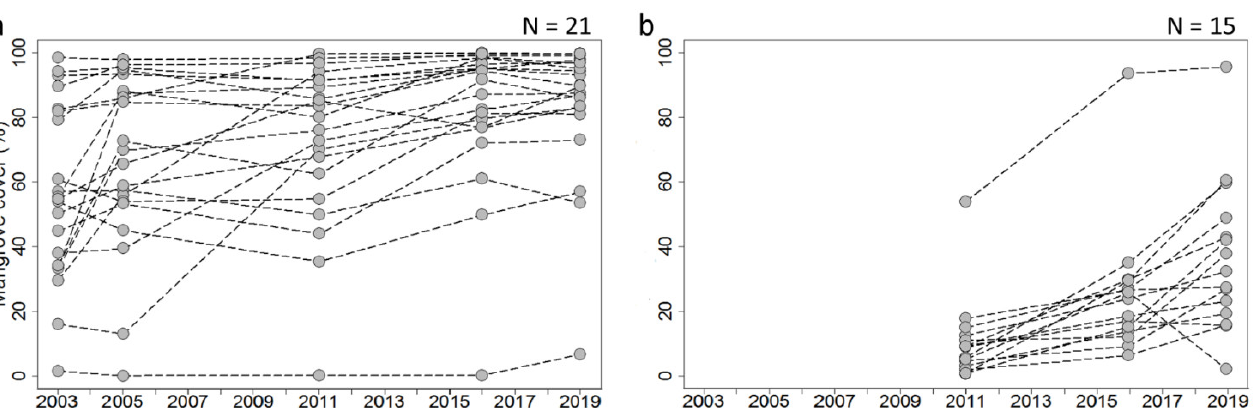
Figure 8. Changes observed in the land-cover of Pichavaram mangroves and the surrounding areas from the visual inspection of the VHRS images (image excerpts on the right ) in combination with a 2016 color-composite image provided by Google Earth ( left ). Aquaculture expansion in the vicinity of the mangrove forest ( a – e ), check-dam construction in freshwater channel to Pichavaram ( f – j ), and progressive shoreline erosion ( k – o ) can be easily identified and monitored.